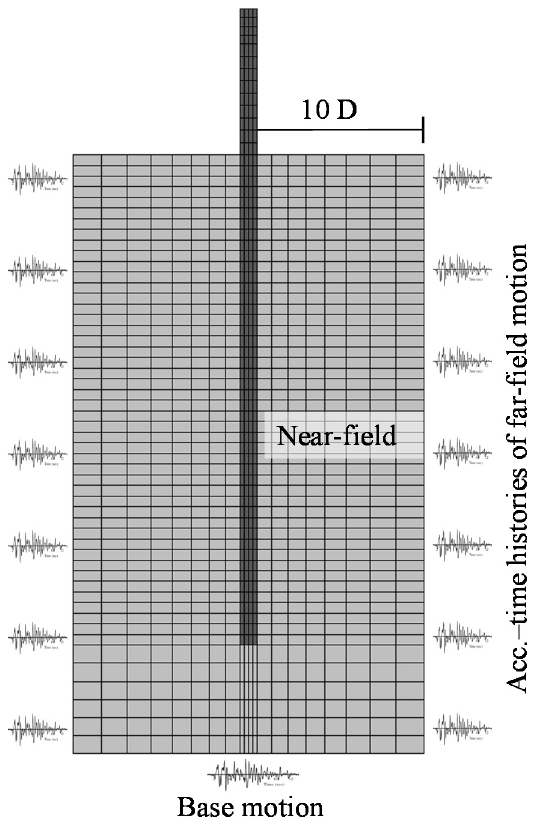
Figure 4. Schematic of the simplified continuum modeling method.